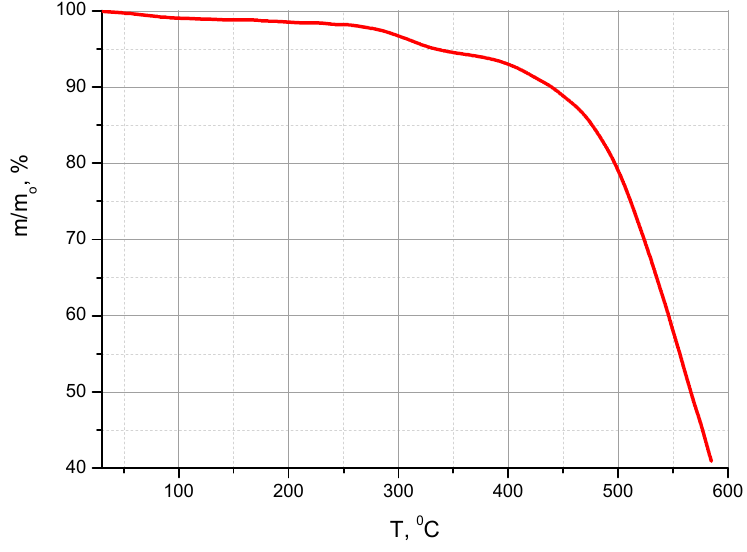
Figure 8. TGA curve of the co-PBOI membrane film.